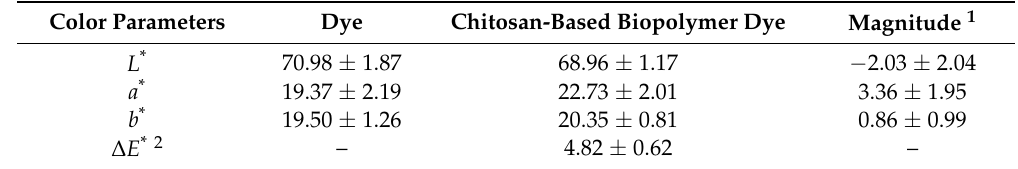
Table 3. Color differences of poplar veneers dyed with Acid Red GR and chitosan-based biopolymer dye. Color